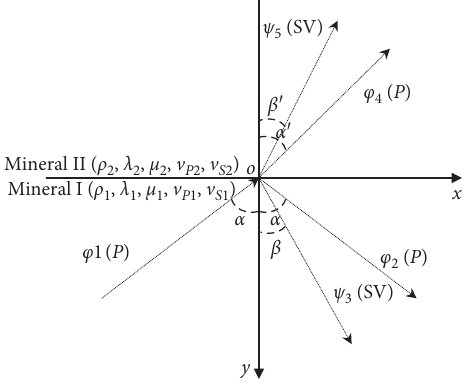
Figure 7: Propagation of AE P-wave on mineral boundaries.